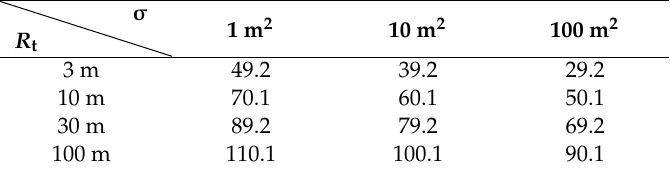
Table 6. Calculated values of maximal noise figures ( F Smax ) (dB) of TS circuits causing the degradation of the SNR Rt by 1 dB. R t